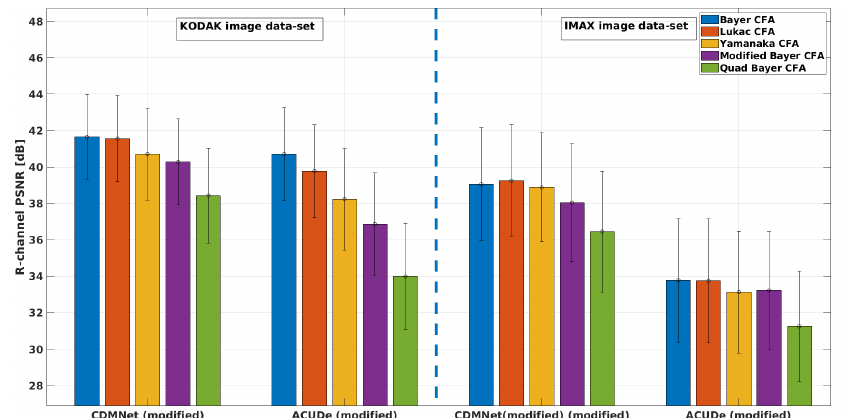
Figure 6. Average PSNR (red channel) results with standard deviation of the mean: for the two modified generic algorithms (“CDMNet modified” and “ACUDe modified”), for the two data-sets (“KODAK” and “IMAX”), for five different Bayer-like patterns (Bayer, Lukac, Yamanaka, Modified Bayer and Quad